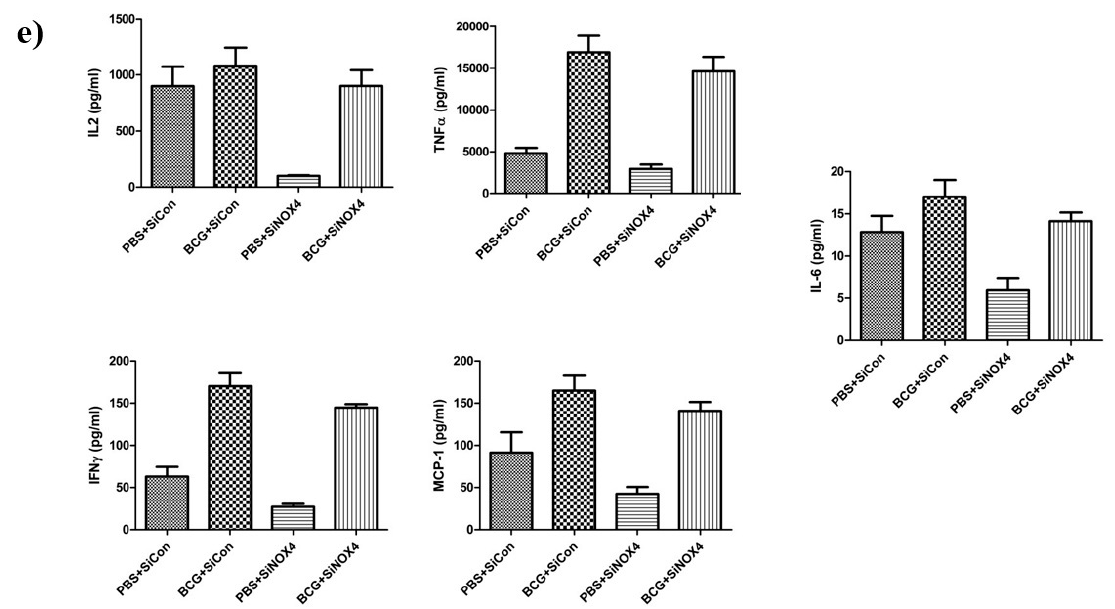
Figure 8. BCG-induced pleurisy and accumulation of cells in the pleural cavity. ( a ) Total number of cells in the pleural cavities in four groups (PBS + SiCon group, BCG + SiCon group, PBS + SiNOX4 group, and BCG + SiNOX4 group) Seven mice per group were analyzed. ( b ) Bacterial load in pleural effusion in four groups. ( c ) Bacterial load in spleen in four groups. ( d ) Photomicrographs from cytospin stained with Giemsa. ( e ) Cytokine levels (Interferon- ɤ , IL-2 TNF- α , MCP-1, and IL-6) were assessed in the pleural fluid. * p < 0.05.